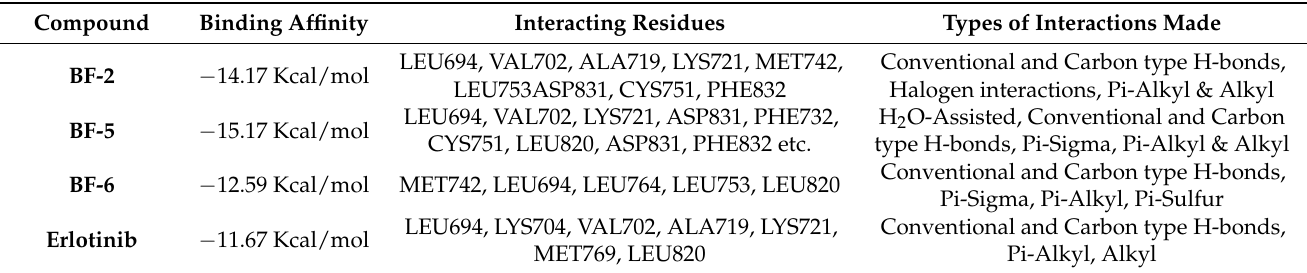
Table 3. Binding affinities and other docking parameters of BF-2, BF-5, and BF-6 with EGFR.